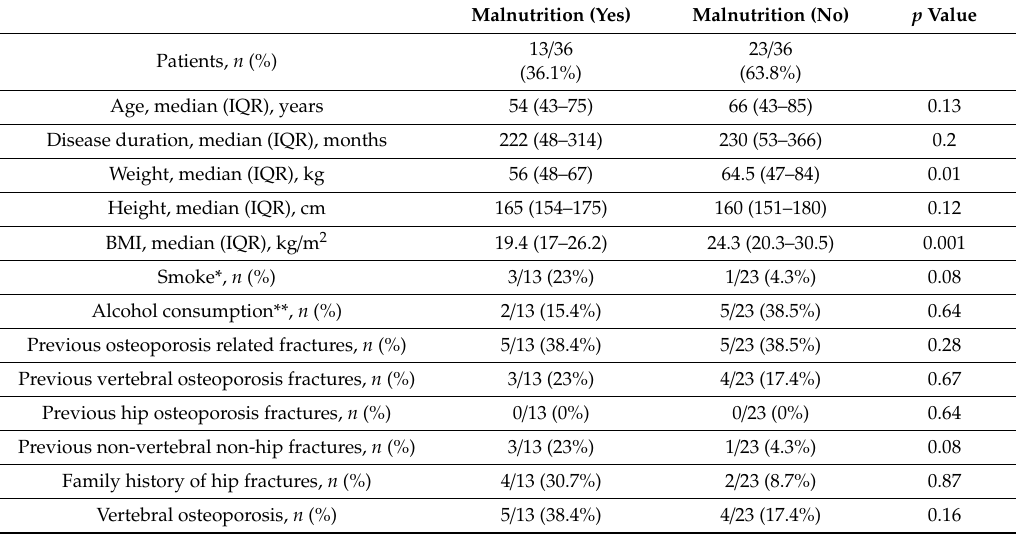
Table 1. Comparisons of bone parameters between malnourished and non-malnourished systemic sclerosis (SSc)